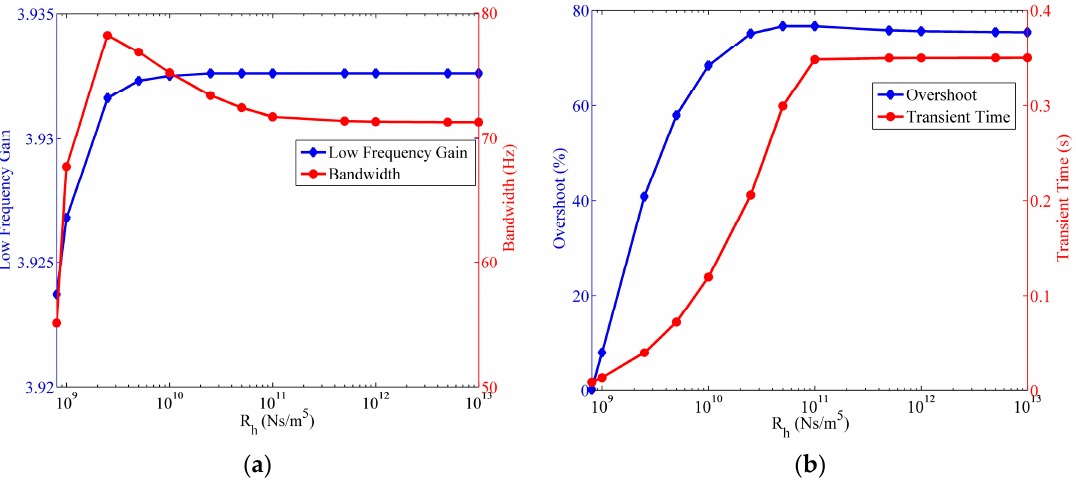
Figure 14. Relationship of the fluidic system indexes versus the hydrodynamic resistance of the porous transducer, where a = 20 m/s, R = 25 mm, r = 4 mm. ( a ) Variation of the low frequency gain and the bandwidth; ( b ) variation of the step response overshoot and the transient time.